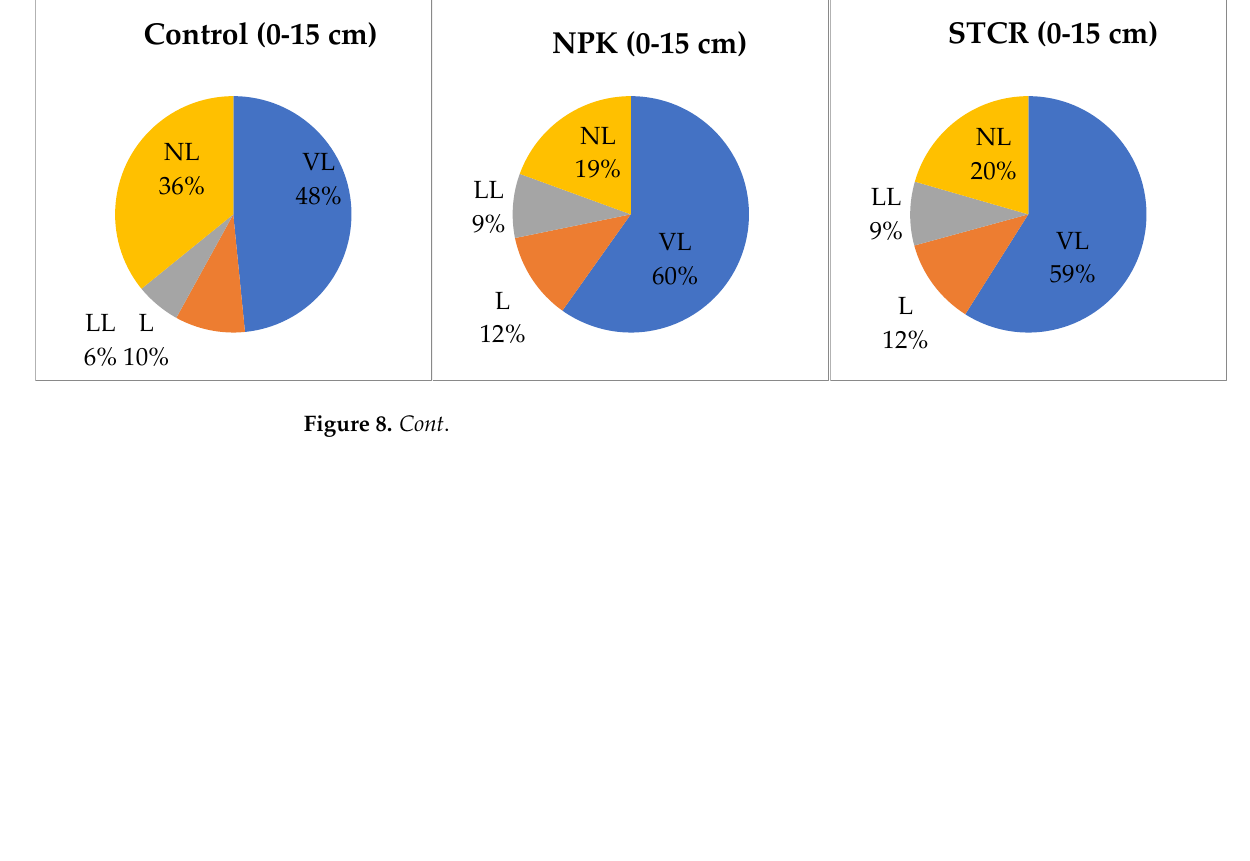
Figure 7. Effect of nutrient management on SMBC. Means ± standard deviation of different treat- ments followed by the different lower-case letter (a–d) are significantly different at p < 0.05 level of significance according to DMRT.